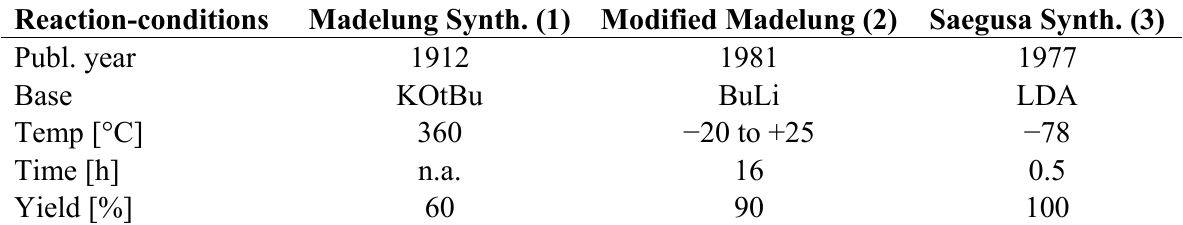
Table 1. Reaction data of indole syntheses ( 1 )–( 3